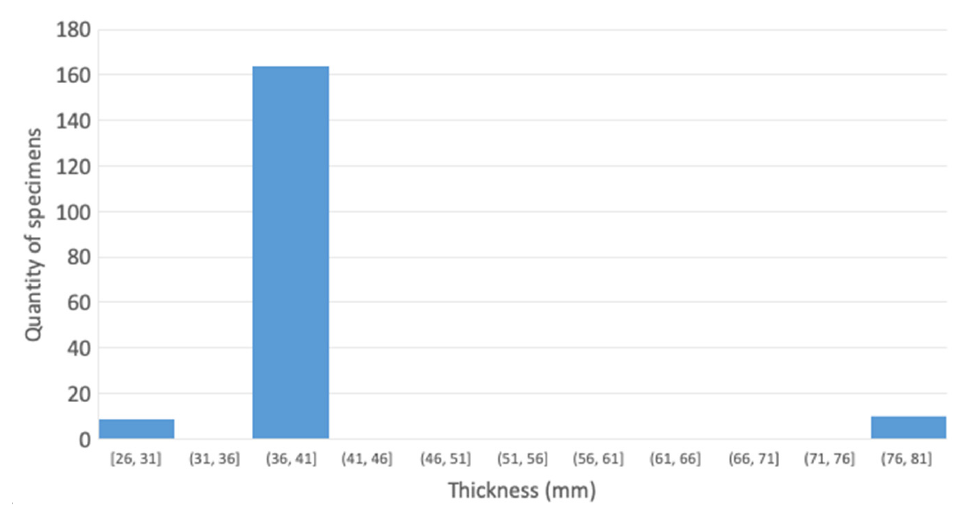
Figure 7. Histogram of thickness with CP T-joint Figure 9. Histogram of thickness with CP T-joint samples . Figure 9. Histogram of thickness with CP T-joint samples .